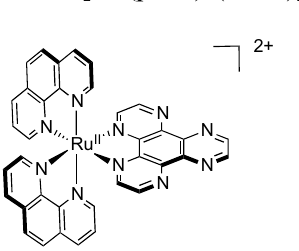
Figure 24. [Ru(phen)